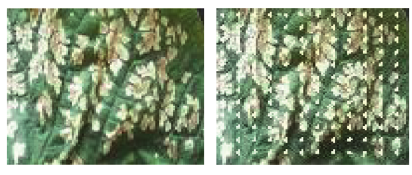
Figure 6: HOG visualization.